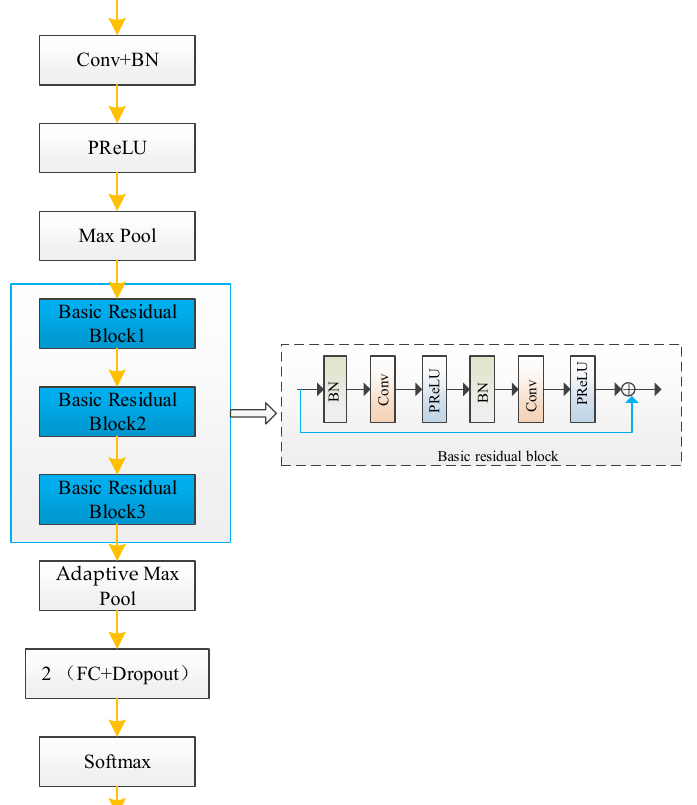
Figure 6. The structure of basic residual block.